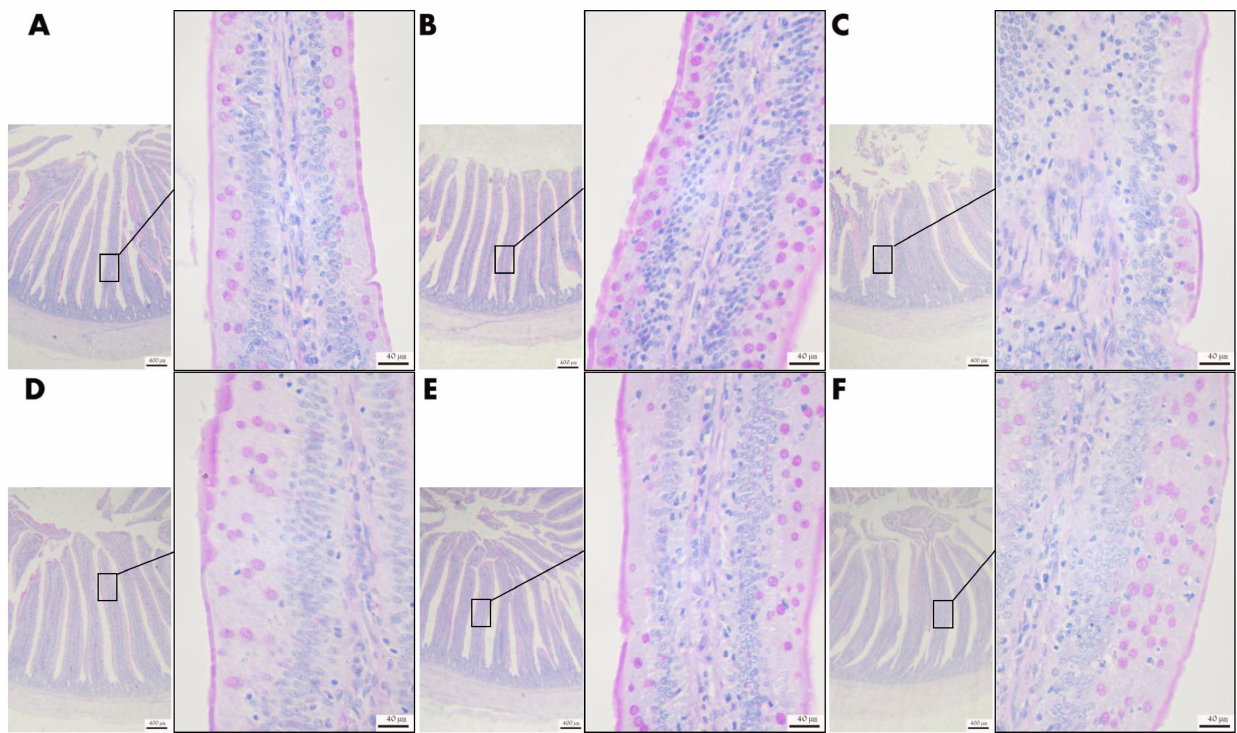
Figure 6. Effects of different levels of VD 3 supplementation on jejunal polysaccharide secretion in the